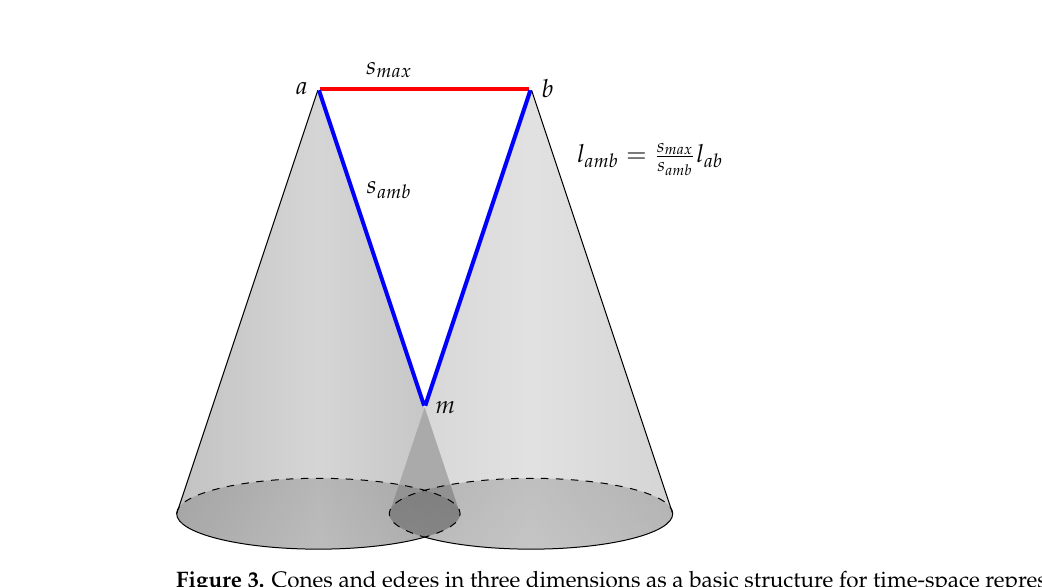
Figure 3. Cones and edges in three dimensions as a basic structure for time-space